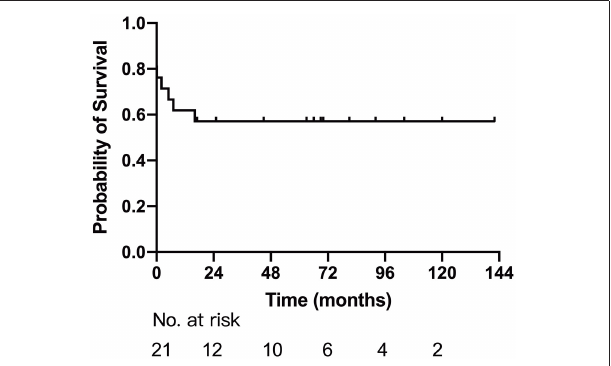
FIGURE 2 | Survival for patients after first-stage palliative surgery.